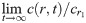
Steady-state dimensionless autocatalyst concentration profiles.Steady-state dimensionless autocatalyst concentration limt→∞c(r,t)/cr1 profiles as functions of dimensionless position r for boundary condition c
r1 > 0 and Thiele modulus Φ < π: Φ = 0.25π (red open triangles), Φ = 0.5π (blue open circles), Φ = 0.75π (green open diamonds), Φ = 0.9π (black open squares). At r = 0, c/c
r1 → ∞ as Φ → π.